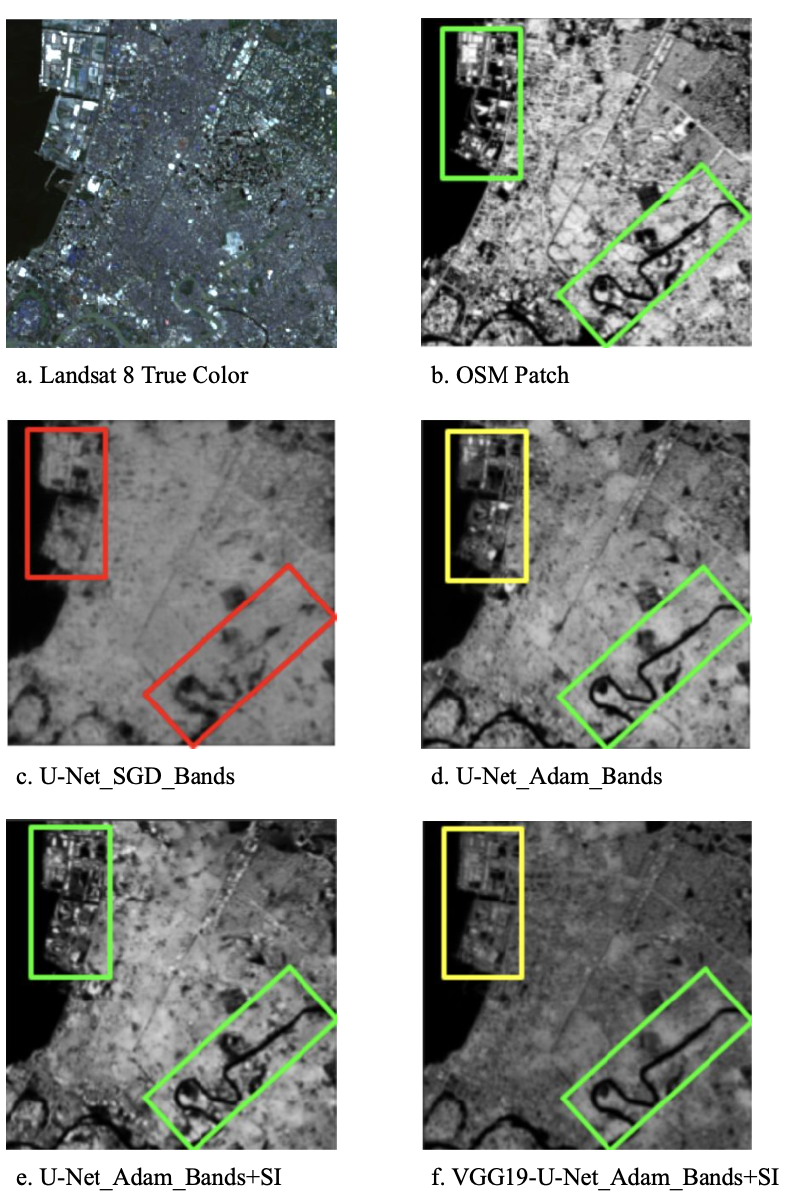
Figure 7. Impervious surface predictions from the four deep learning models on an image represent- ing an urban